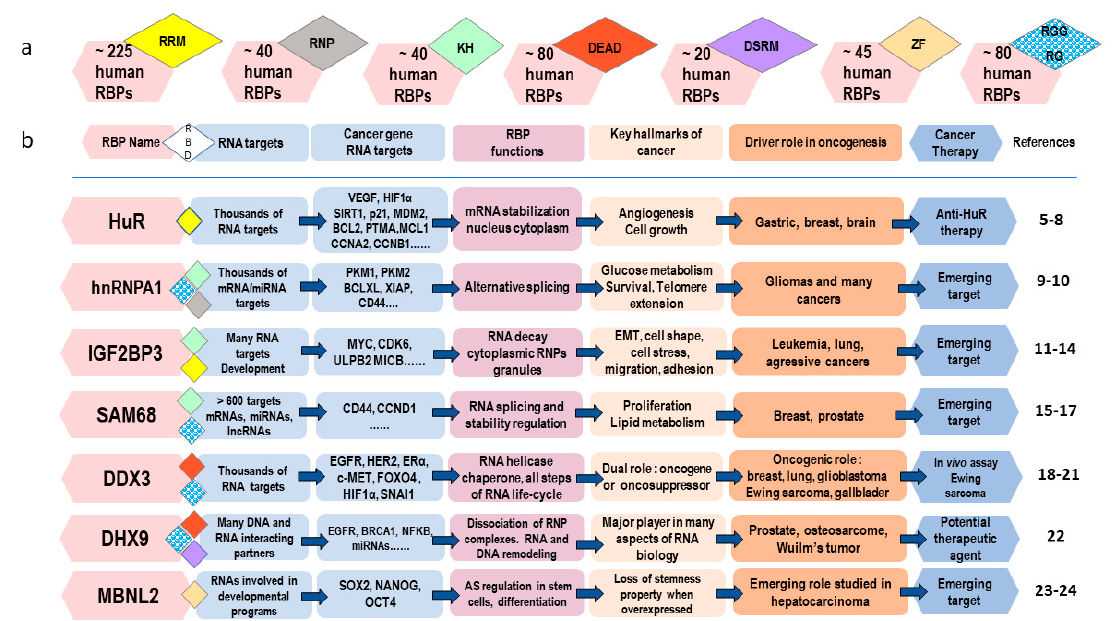
Figure 1. Relationships between RNA-binding domains (RBDs), RNA-binding proteins (RBPs), their RNA-binding partners, and downstream biological processes, with regards to their potential in cancer therapy. RBPs with altered expression or/and functions participate as drivers in oncogenesis and might be interesting therapeutic targets for cancer treatment [5–24]. A single RBP is able to bind several hundreds or thousands of RNA targets. Thus, the precise role and signaling pathways downstream each RNA target need to be carefully studied and elucidated to evaluate its potential in cancer therapy. More than 600 RBDs have been identified in the human genome. ( a ) Of the 692 estimated mRBPs, 405 contain an RNA recognition motif (RRM), a K homology (KH) domain, a DEAD motif (containing the amino acid sequence D-E-A-D (Asp-Glu-Ala-Asp)), a double-stranded RNA-binding motif (DSRM), a zinc-finger (ZF), or RGG/RG (i.e., Arg-Gly-Gly/Arg-Gly) motifs [2–4]. ( b ) Examples of RBPs representative of RBD diversity and with a potential importance in cancer therapy. The RNP domain is a RRM subclass found in heterogeneous nuclear ribonucleoproteins (hnRNP) family RBPs. As shown, many RBPs contain several RBDs. RRM, KH, DEAD, DSRM, RNP, and ZF are canonical RBDs able to adopt secondary structures with α -helices and β -sheets. RGG/RG motifs are intrinsically disordered regions (IDRs) with low ordered secondary structures, resulting in flexibility enabling them to bind with many partners. They are recognized as important emerging players in the mRNA life-cycle [2,25–27]. Each of the seven RBDs shown is schematically depicted with a hexagonal shape and with a specific color (as specified by the color code in ( a )). RGG/RG motifs are highlighted by a two-color representation (blue and